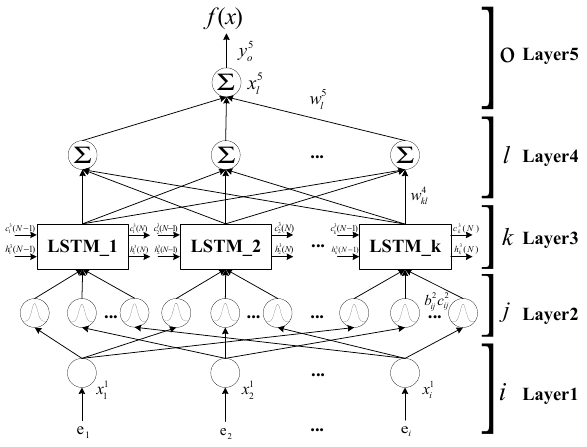
Figure 1. Block diagram of the NFNN.